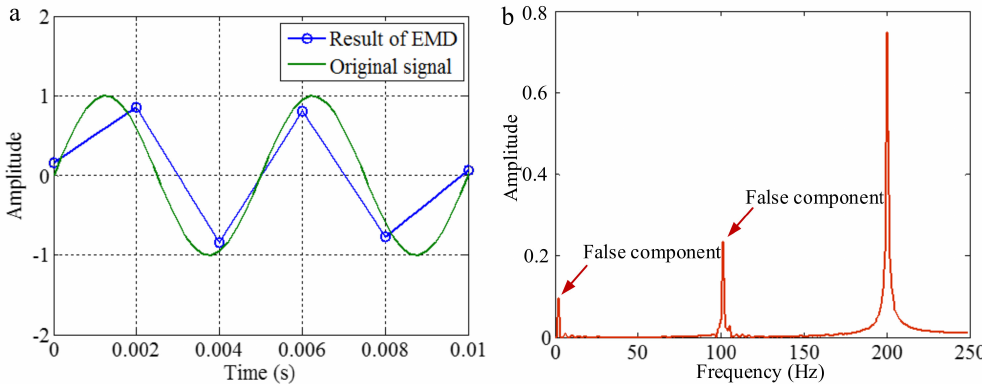
Figure 5. The EMD result of the signal of 200 Hz with a sampling frequency of 0.5 kHz and the corresponding Fourier spectrum: ( a ) the results of EMD and ( b ) the Fourier